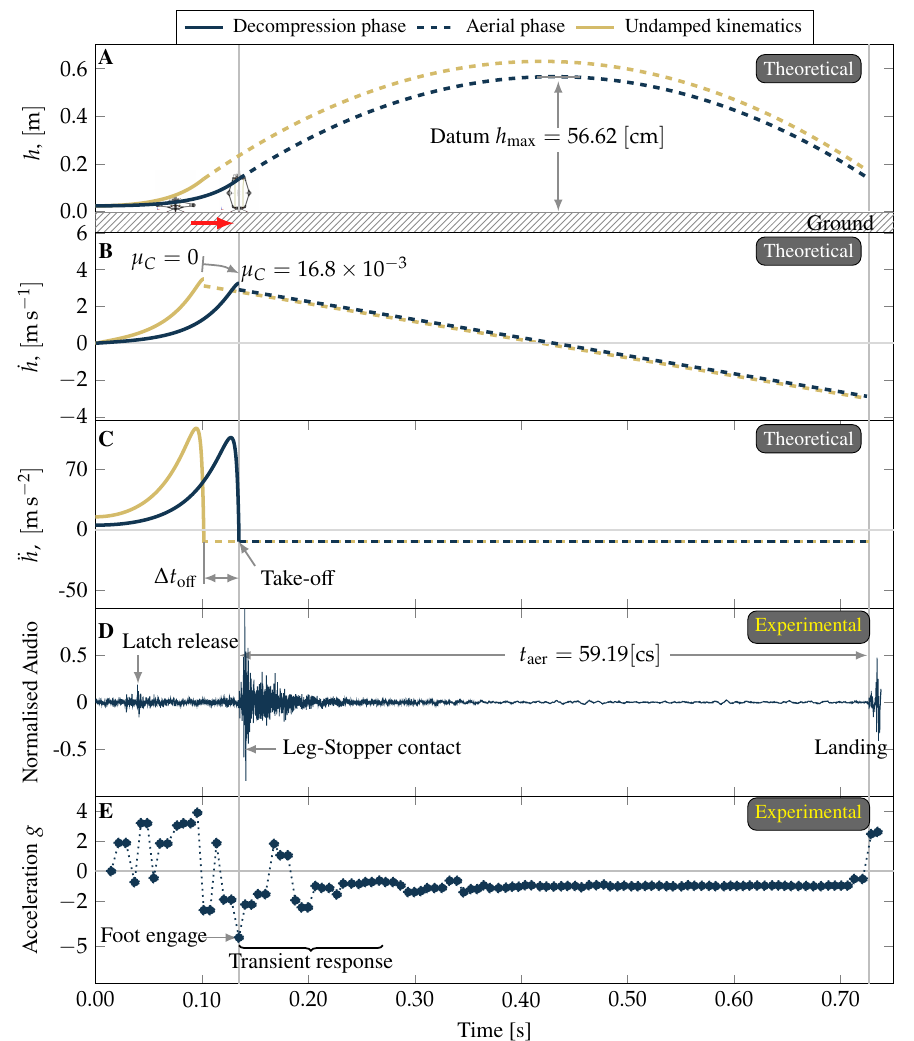
Figure 11. ( A – C ) kinematic curves for the CLOVER robot laboratory demonstrator. After take-off, a transient response in the linkage is observed in ( E ). Ground contact (landing phase) is observed as a sudden signal transition in ( D , E ). The onboard acceleration readings are bound by the accelerometer capability to approximately 4 ±